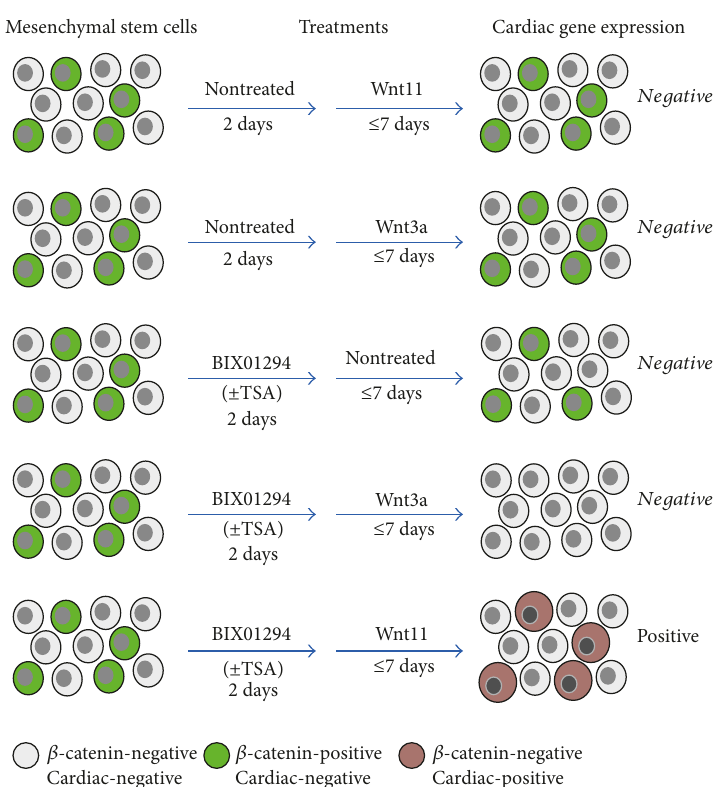
Figure 10: Model of epigenetic and Wnt regulation of cardiogenesis. Results presented in this study indicate that BIX01294 induces a precardiac phenotype from MSCs and acts cooperatively with Wnt11 in promoting both cardiac di ff erentiation and inhibiting the intracellular accumulation of β -catenin. Inhibition of β -catenin accumulation by cells of the early mesoderm has been postulated to be a key element in the initiation of heart formation. Thus, we hypothesize that the BIX01294 prerequisite for generating cardiac phenotypes from MSCs is twofold: (1) to promote gene expression that is in accordance with a precardiac phenotype and (2) cooperatively allow Wnt11 to reduce cellular β -catenin levels, thereby initiating cardiac di ff erentiation of the treated